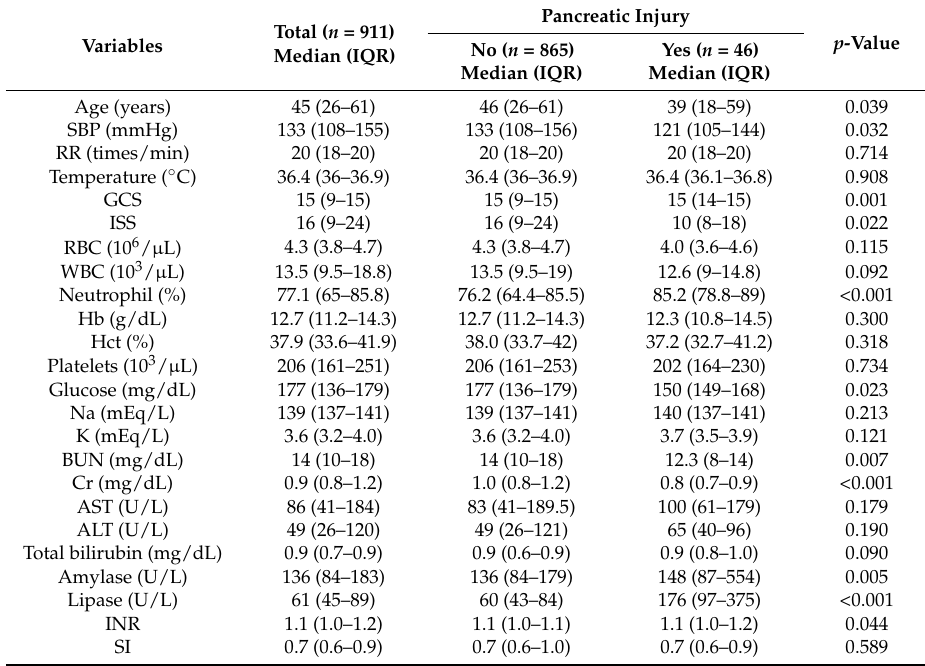
Table 2. Comparison of continuous variables of patient and injury characteristics, used in the decision tree model, between patients with and without pancreatic injury.